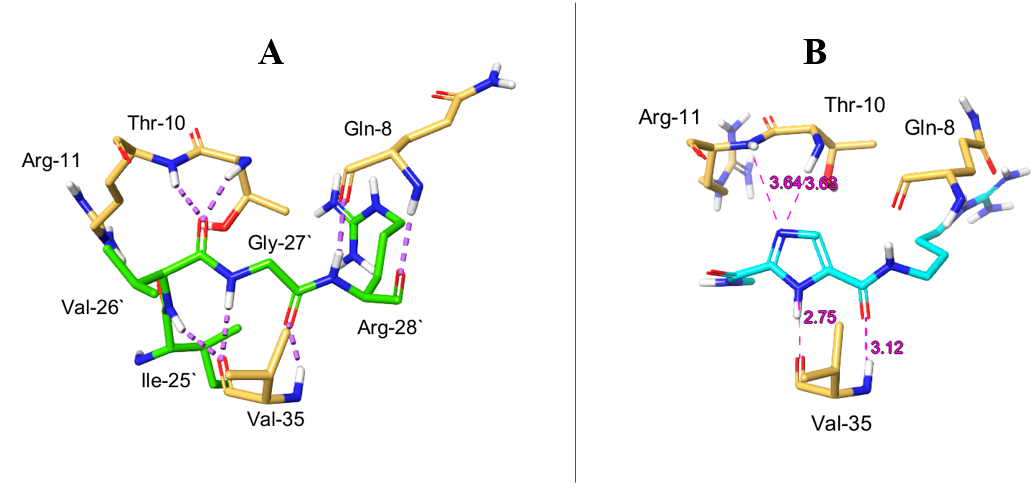
Figure 2. The conservation of important hydrogen bonding in the structure-based design. ( A ) Interactions of NS4A (light green) with some NS3 residues (yellow). ( B ) Designed imidazole-2,5-dicarboxamide (light blue).